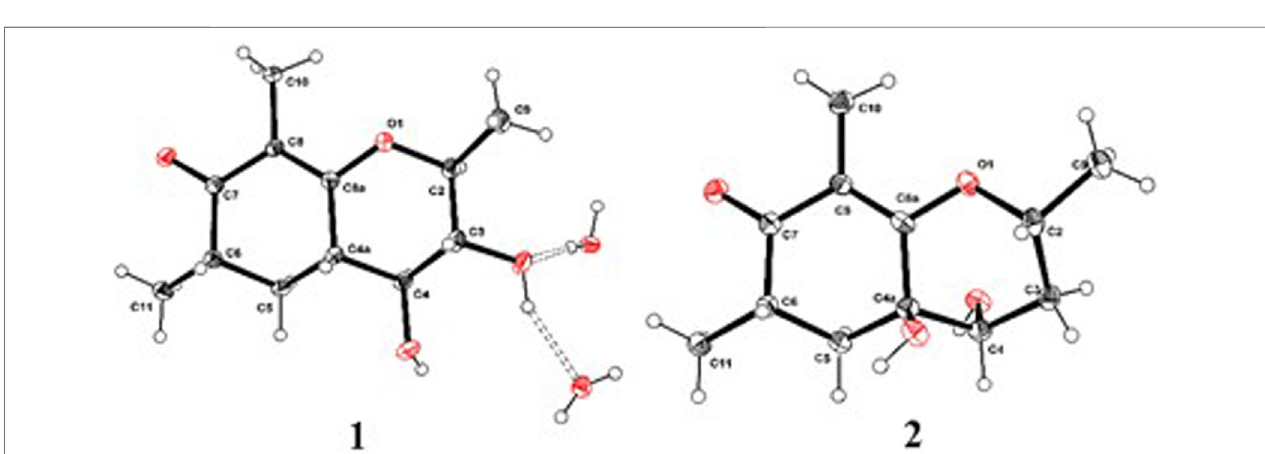
FIGURE 4 | ORTEP drawings of the X-ray structures for compounds 1 and